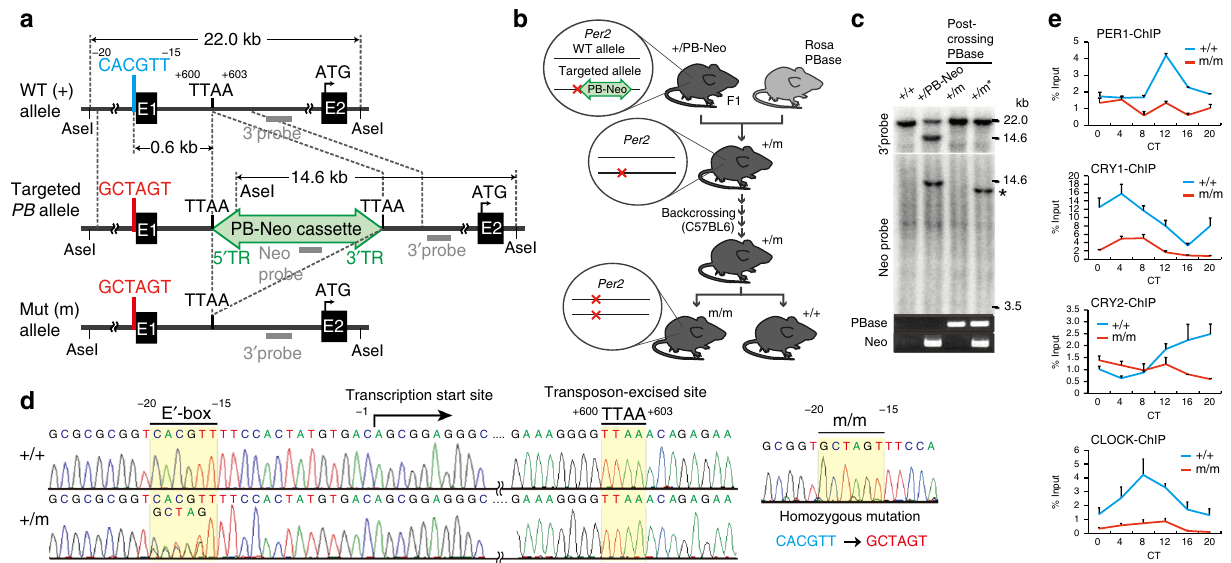
Fig. 1 Generation of mice carrying a targeted mutation at Per2 E ′ -box. a Genome modi fi cation strategy using the piggyBac transposon. The CACGTT Per2 E ′ -box was mutated to GCTAGT. Top line, genome architecture of the mouse Per2 gene; E1, exon 1; E2, exon 2; Blue, wildtype E ′ -box; Red, mutated E ′ -box; Green, piggyBac transposon carrying a neomycin-resistant gene (PB-Neo cassette) inserted at a genomic TTAA site ( + 600 to + 603); Gray bars, Southern blot probes. Numbering shows the position relative to the putative transcription start site ( + 1). b Interbreeding scheme. Mice heterozygous for the targeted allele ( + /PB-Neo) were intercrossed with ROSA26-PBase mice. The resultant mutant mice without the marker cassette ( + /m) were backcrossed into the C57BL/6J strain. c Southern blot and PCR analysis showing the insertion ( + /PB-Neo) and excision ( + /m and + /m*) of the piggyBac transposon. *, a reintegrated PB-Neo fragment. d Genomic DNA sequences of WT ( + / + ) and Per2 E ′ -box mutant ( + /m and m/m) mice, illustrating the precise mutation of the E ′ -box and seamless excision of the PB-Neo cassette from the TTAA site. Heterozygous ( + /m) mouse sequences exhibit dual signals for CACGTT and GCTAGT at the E ′ -box. e ChIP values for WT ( + / + ) and homozygous mutant (m/m) mouse liver sampled at 4 h intervals for 24h on the fi rst day in DD. Values are means±s.e.m. of three technical replicates. Source data for ( c ) and ( e ) are provided as a Source Data fi le